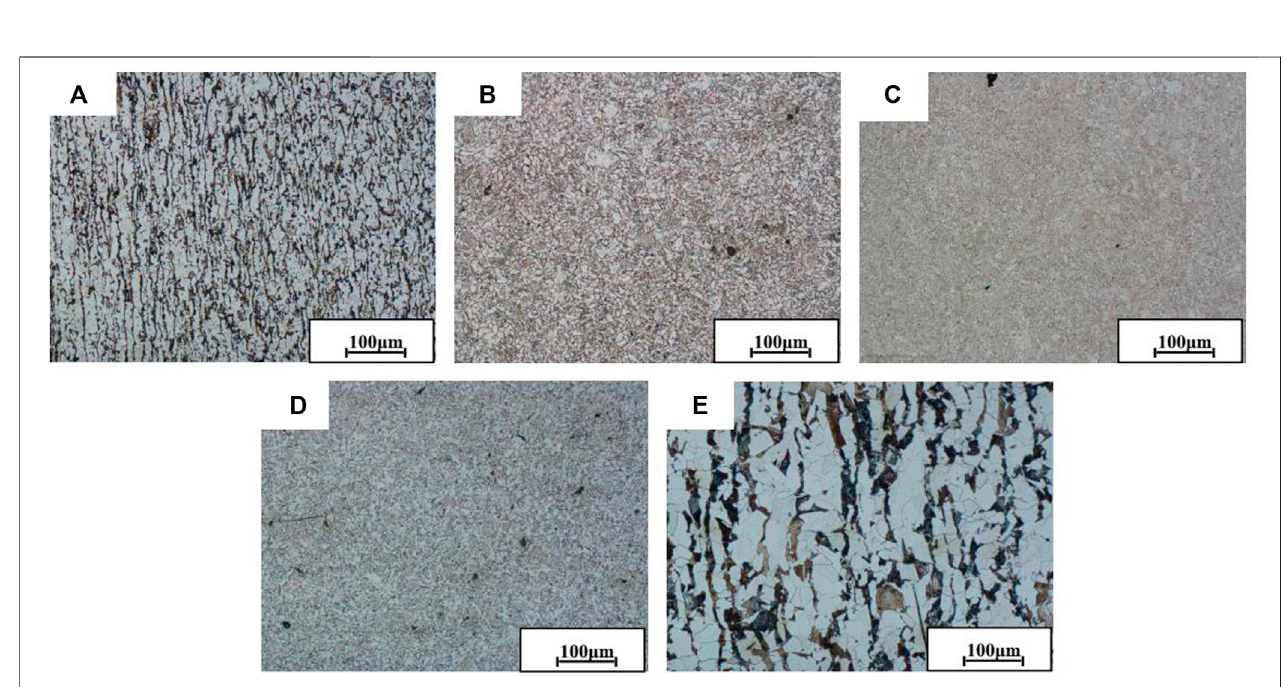
FIGURE 3 | Metallographic images of FSW joint at different zones [ (A) stud zone (SZ), (B) upper – heat-affected zone (U-HAZ), (C) welded zone (WZ), (D) lower – heat-affected zone (L-HAZ), and (E) base metal zone (BMZ)].